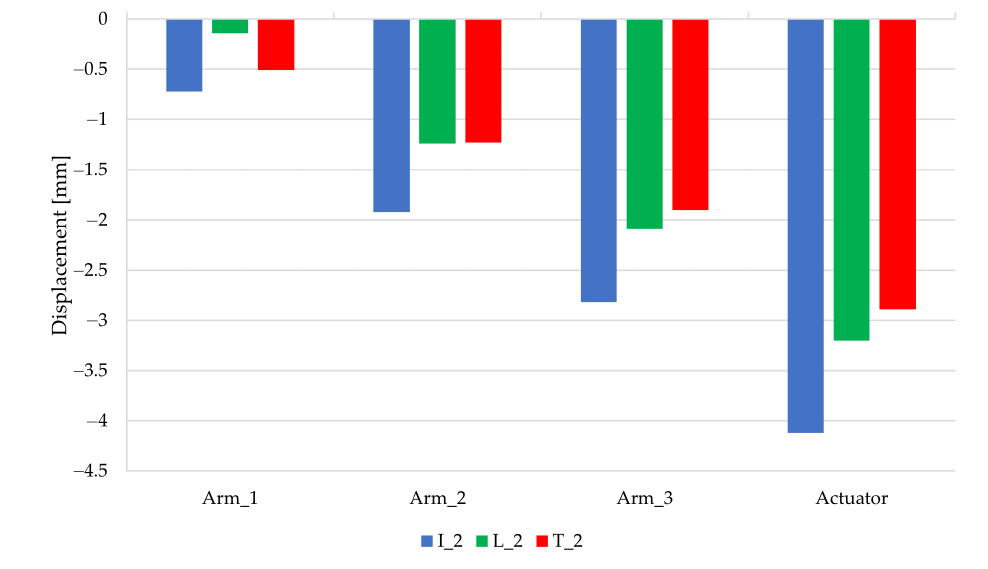
Figure 12. Maximum displacement of the component in the z -axis (State_2 vs.